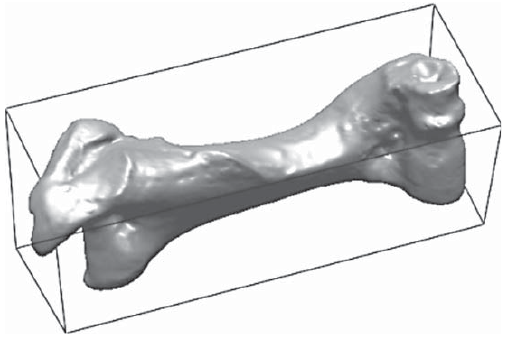
Fig. 1. Scanned humerus model and circumscribed cube to bone.